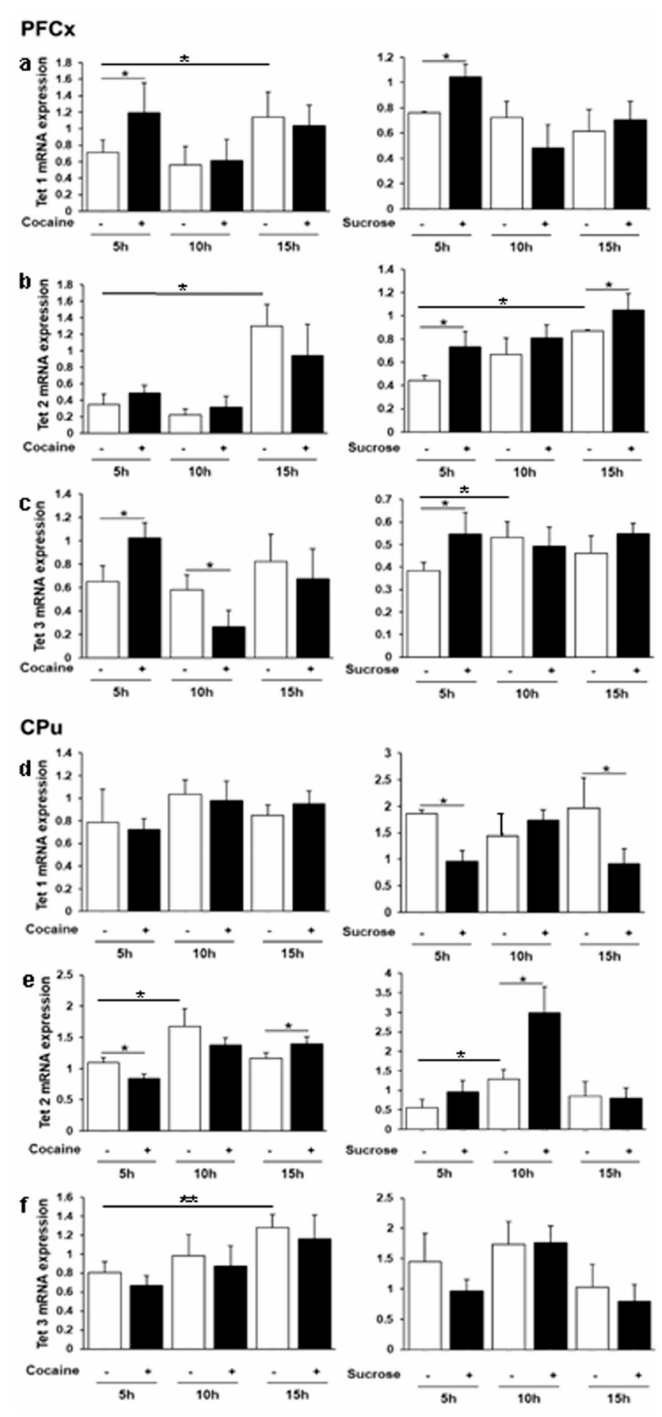
Figure 3. Tet 1,2 and 3 mRNA expression in the PFCx and in the CPu in response to cocaine and sucrose intake. Relative Tet 1 , 2 and 3 gene expression was analyzed in the PFCx ( a – c ) and in the CPu ( d – f ) after the last passive administration at various times corresponding to ZT illustrated in Figure 1. Data represent the mean ± SEM, n = 4–5 per group. Statistical analysis performed was one-way ANOVA followed by Newman-Keuls post hoc test when required. Significant differences between control and treated groups and within control groups relative to ZT 6 (5 h after administration) are indicated. * p < 0.05, ** p <